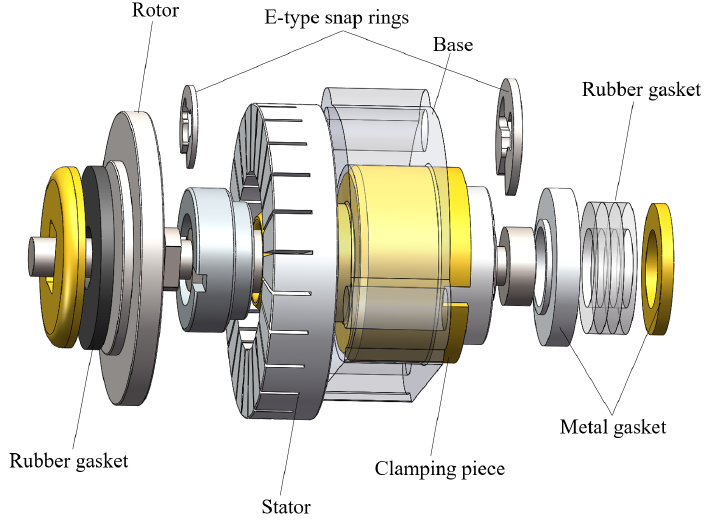
Figure 1. Structural scheme of the miniature traveling wave rotating ultrasonic motor. The stator is equipped with a circular piezoelectric ceramic element, which is po- larized in the thickness direction, as shown in Figure 3. The unpolarized region of the circular piezoelectric ceramic element occupies 1/4 wavelength λ , which just satisfies the spatial phase difference π /2. The polarization regions at both sides form A and B phase, respectively. The manufacturing material is copper alloy. The piezoelectric ceramic sheets used in the MTWRUM are PZT-8 series with a thickness of 0.5 mm. The mechanical properties of aluminum alloy and piezoelectric ceramic sheets are shown in Table 1. Some other parameters of the piezoelectric ceramic sheets used for finite element analysis are listed below.